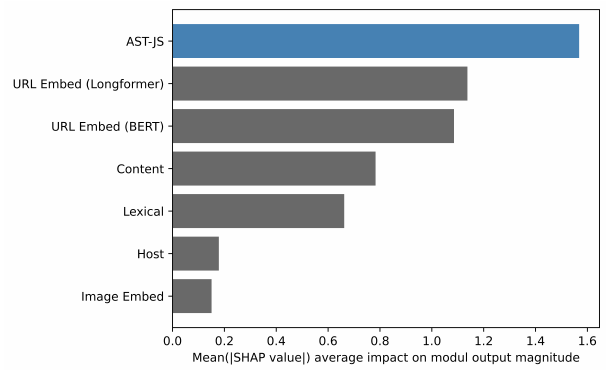
Figure 7. Average SHAP value for each feature category with a dataset that has JavaScript